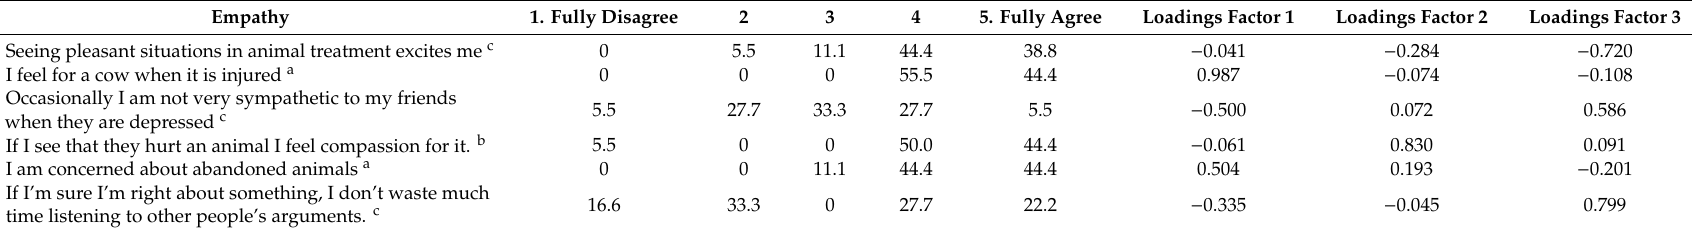
Table 2. Percentages of responses (from 1 – fully disagree to 5 – fully agree) characterizing handlers ( n = 18) empathy toward cattle and handling behavior; and loadings of the four factors estimated by factor analysis for questionnaire